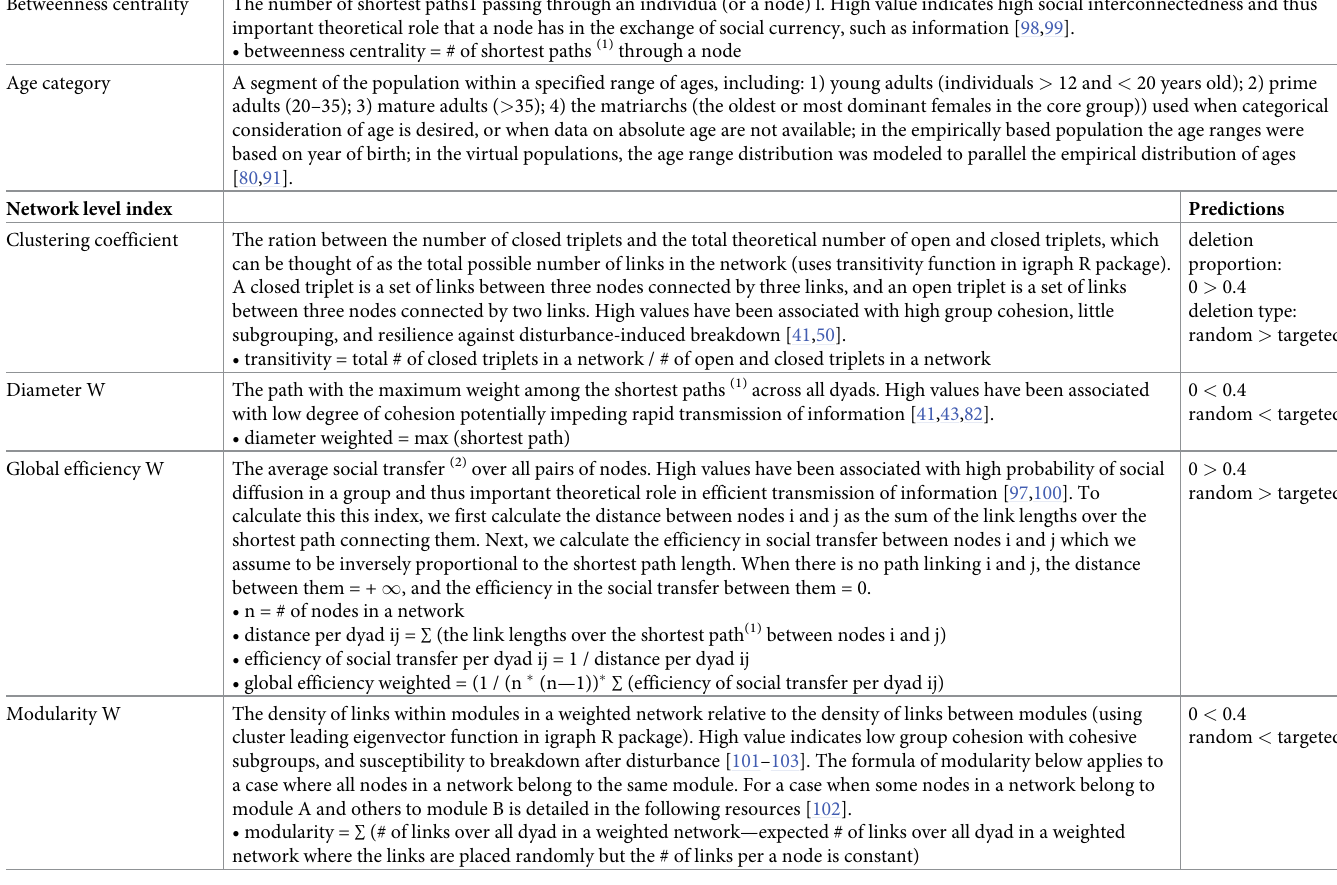
Table 1. Definitions of social influence metrics (i.e., betweenness centrality or age category) network level indices (weighted (W) diameter, global efficiency and modularity, as well as unweighted clustering coefficient) along with formulas we used to calculate them; and the expected outcomes per deletion proportion ranging from 0 to 0.2 in increments of 0.04. and type (i.e., targeted or random). The impact of deletions on each network level index was measured after incremental deletion of the most socially influential individuals while targeting individuals with high betweenness centrality or age category, or when individuals were deleted at random. Our expectations are expressed with a greater- or less-than sign ( > or < ). For instance, we predicted that relative to random deletion, targeted deletion of seniors would result in lower clustering coefficient values; and that higher deletion proportions would also result in lower clustering coefficient values. (1). Our procedure assumes that the higher the weight of a link between two individuals (or nodes), the shorter the distance between them. To reflect this relationship, we define the length of a link as the inverse of its weight. Using the inverse of the weights of the links connecting all pairs of nodes, we calculated all shortest paths in the network [50,97]. (2). Social transfer is a theoretical expression of the efficiency of passing of transmissible currency, such as information, assumed to be diffusing across network links